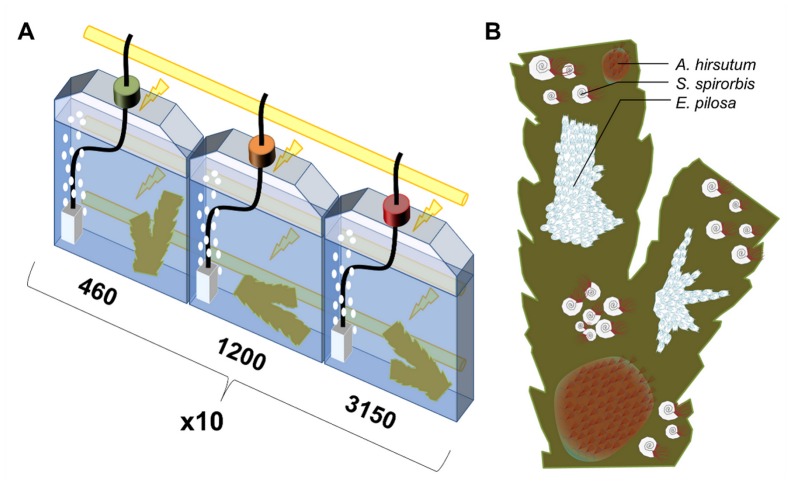
Experimental design.(A) Schematic representation of the incubation system. (B) Schematic representation of one experimental F. serratus section bearing the three epibionts, both sides of the thallus were bearing epibionts.